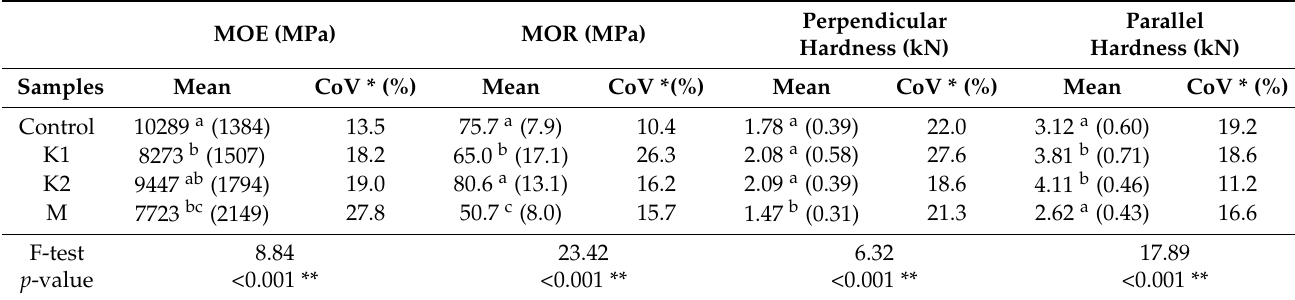
Table 2. Mechanical properties mean values and coefficient of variation of the analyzed studied